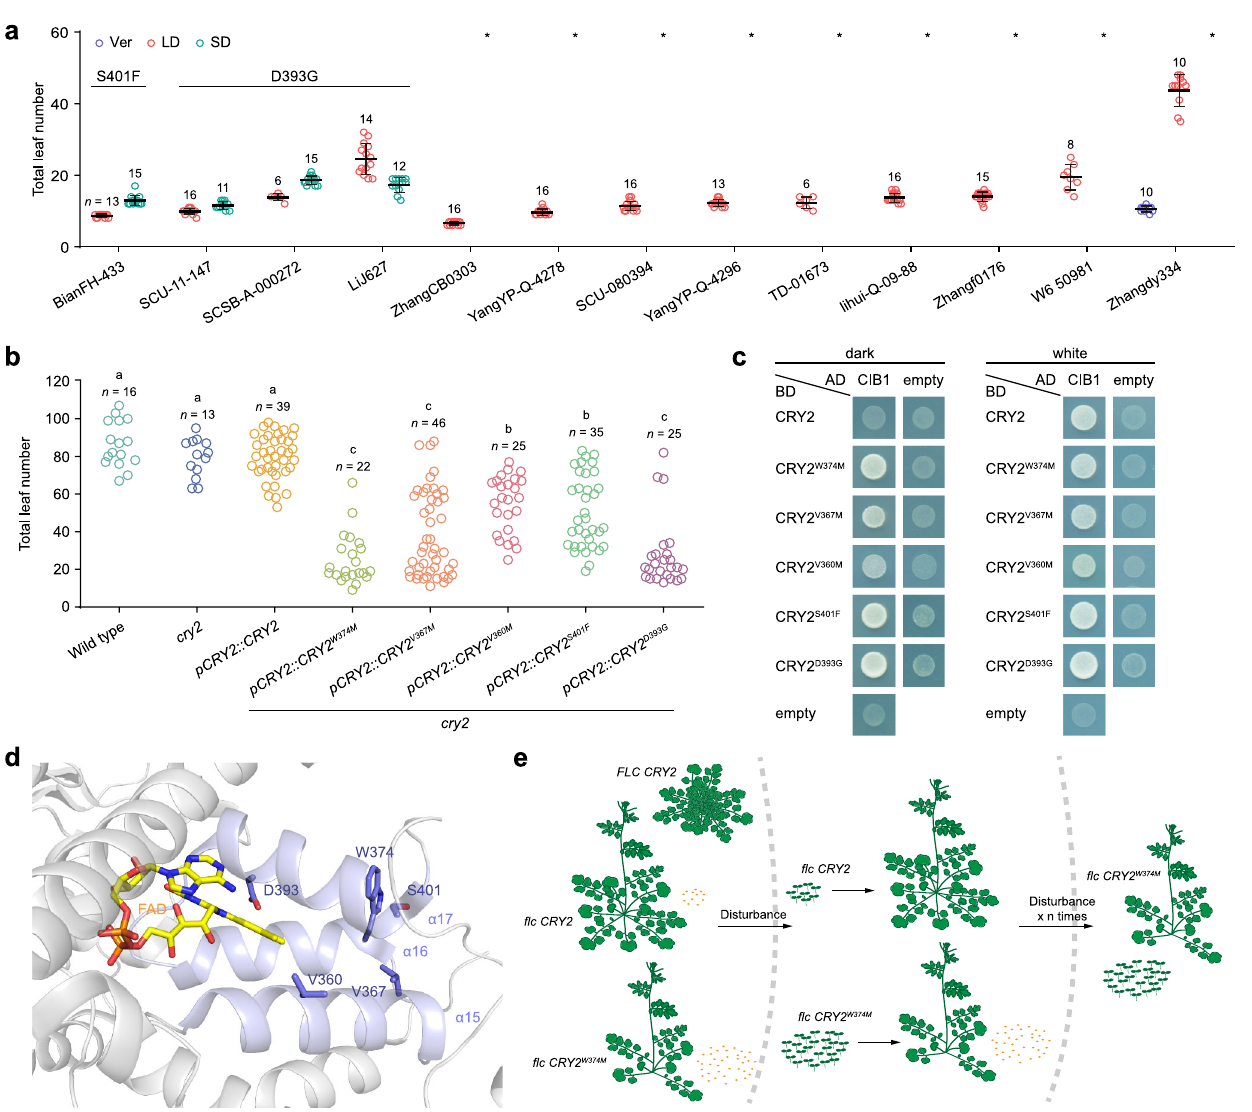
signi fi cant differences as determined by ordinary one-way ANOVA. c Y2H assays showing the interactions between different versions of CRY2 and CIB1. Trans- formed yeast cells were grown on SD/-Leu/-Trp/-His plates supplemented with 5 – 25mM 3-amino-1,2,4-triazole (3-AT) under dark or light conditions. AD, GAL4 activation domain; BD, GAL4 DNA binding domain. d A close-up view of the CRY2 structure (PBD ID 6M79). The FAD molecule and mutated residues are dis- playedassticksandcoloredinyellowandviolet,respectively.Helices α 15 – α 17with mutated residues are colored in light blue. e Proposed model for the evolution of weed ruderality in Brassicaceae. Three genotypes ( FLC CRY2 , fl c CRY2 , and fl c CRY2 W374M )areshown.ThesourcedataunderlyingFig.6a,bareprovidedasaSource Data fi